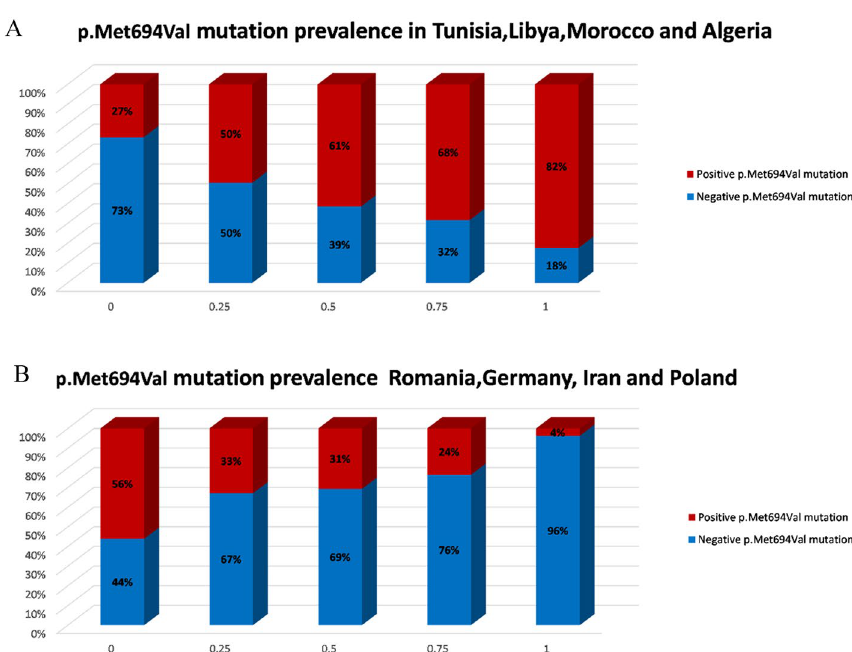
Figure 1. Prevalence of the countries of origin most indicative for the p.Met694Val variant: ( A ) Tunisia, Libya, Morocco, and Algeria are the countries of origin most positively associated with the p.Met694Val variant. ( B ) Romania, Germany, Iran and Poland are the countries of origin most negatively associated with the p.Met694Val variant. Red and blue bars indicate patients who carry and do not carry the p.Met694Val variant, respectively. The x-axis indicates the amount of grandparents from the four countries (0 being none, 1 being all